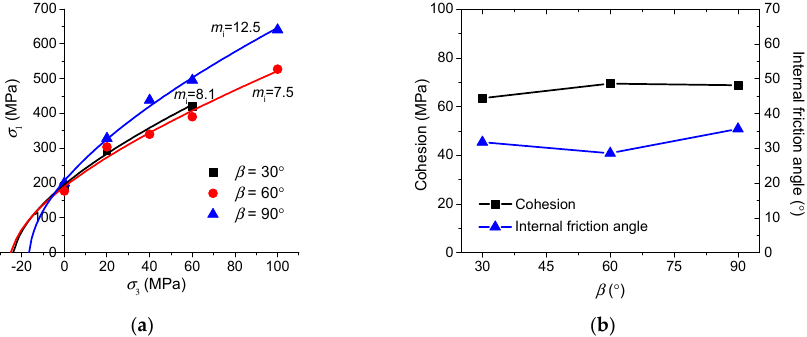
Figure 5. ( a ) Hoek-Brown fitted curves of the Peak strength values of the Shale samples with different oriented weak planes under different confining pressures; and, ( b ) variation of cohesion and internal friction angles of these samples.